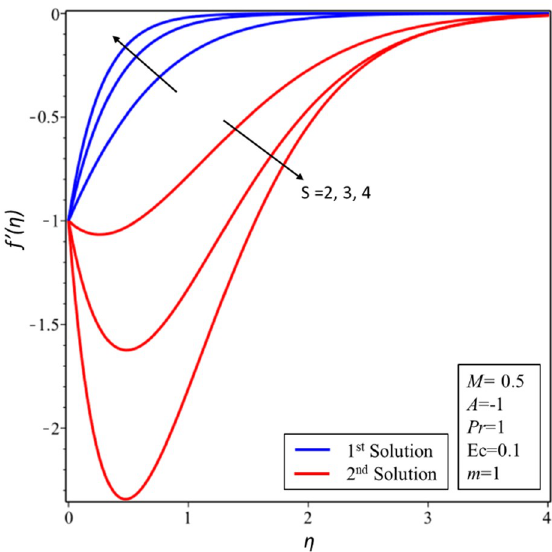
Figure 1. f (cid:48) ( η ) for increasing values of S .